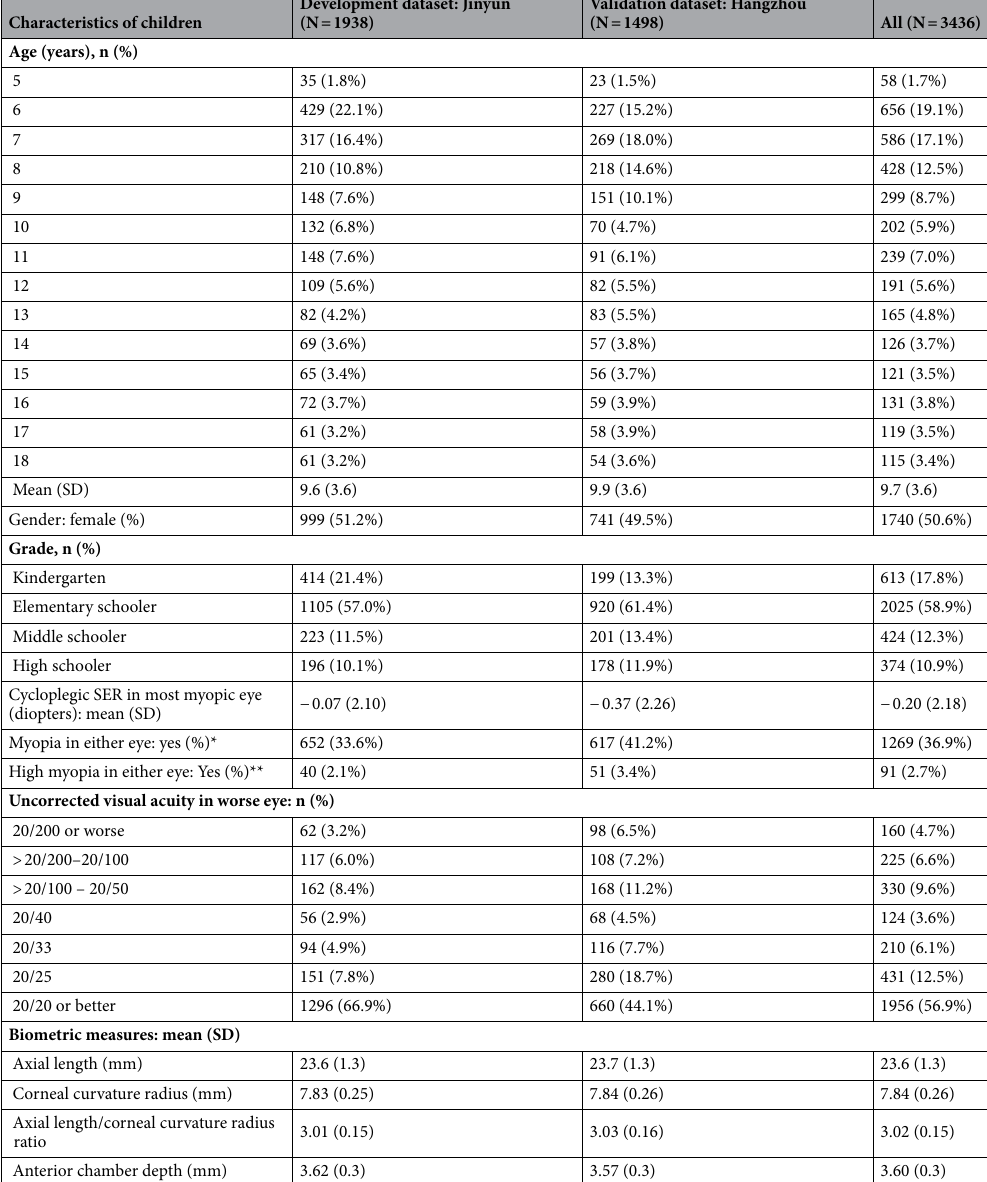
Table 1. Characteristics of school students (N = 3436). SER spherical equivalent, SD standard deviation, SD standard deviation. *Defined as cycloplegic spherical equivalent ≤ − 0.5 D in either eye. **Defined as cycloplegic spherical equivalent ≤ − 6.0 D in either